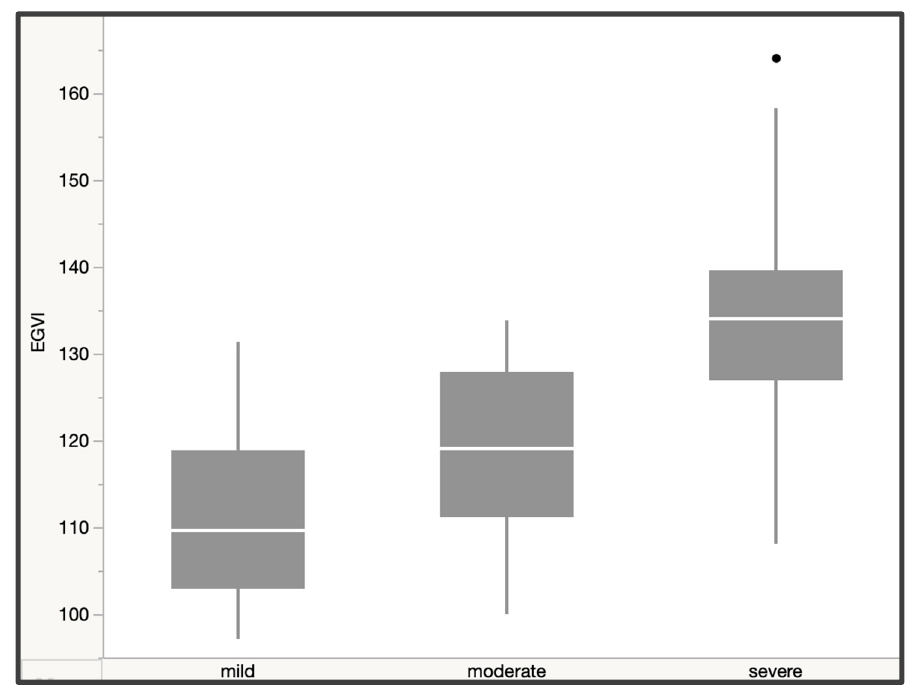
Figure 3. A significant increase in gait variability as measured by the eGVI was observed between severity groups in degenerative cervical myelopathy (DCM)